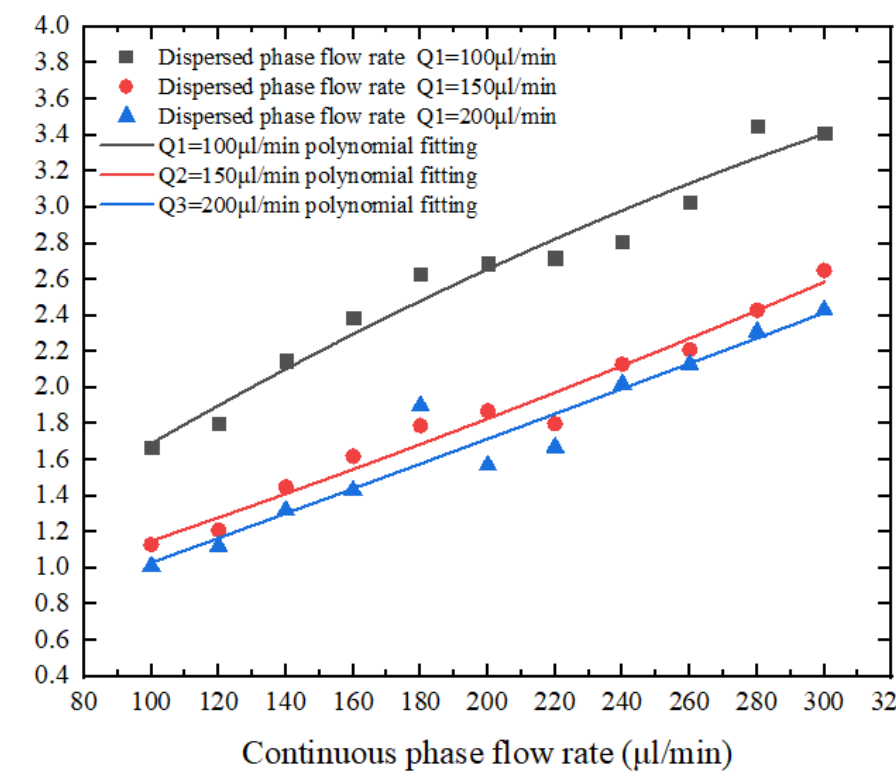
Figure 13. The relationship between the flow velocity of the dispersed phase and droplet size.